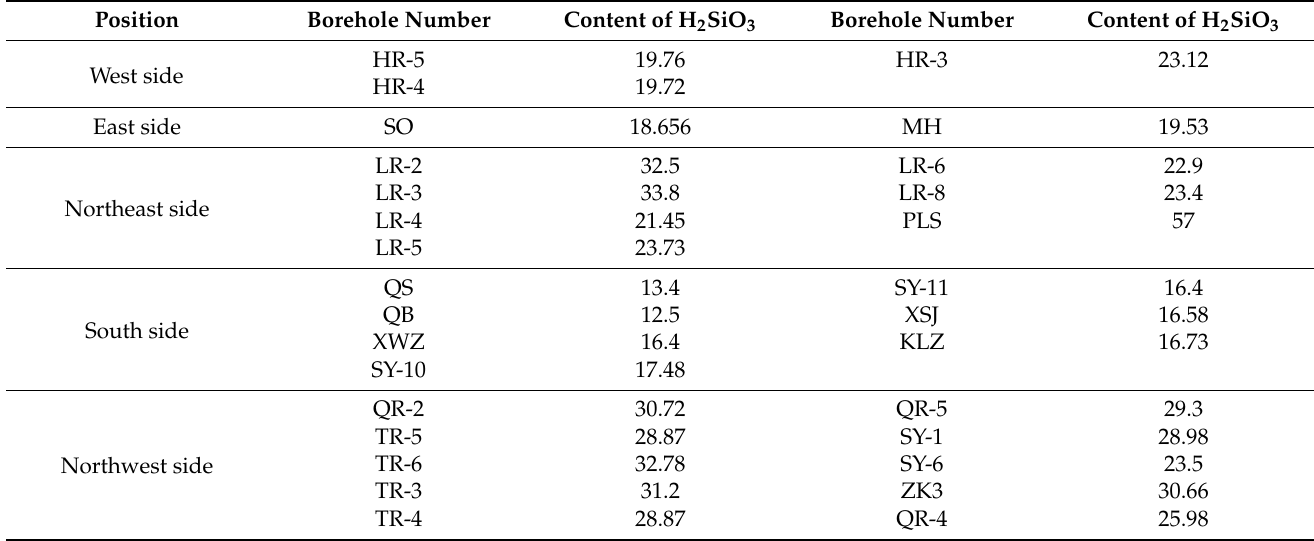
Table 1. The H 2 SiO 3 content of the groundwater samples was collected from different sides of the Ji’nan rock mass (See Figure 2 for the locations of the